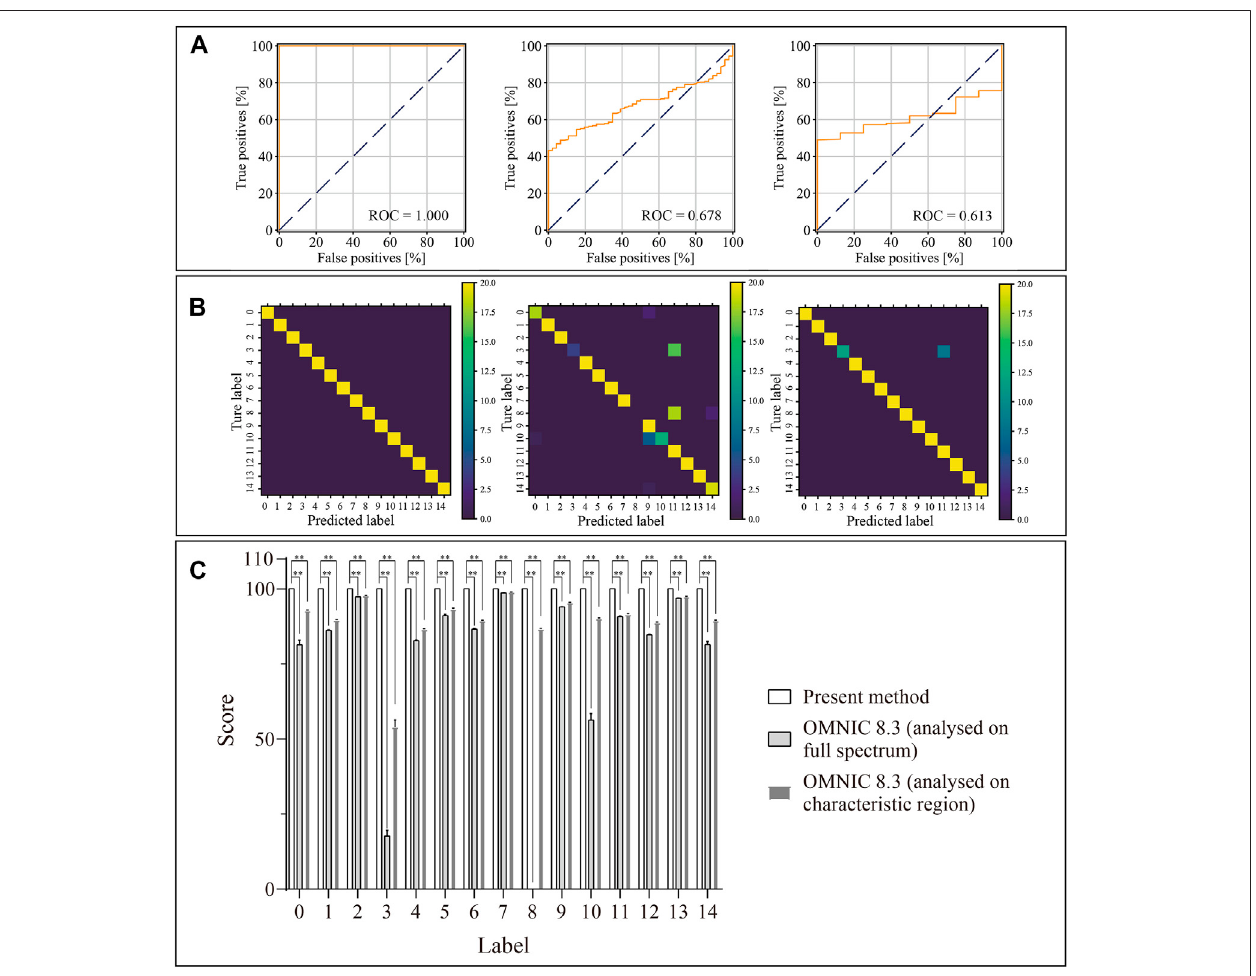
FIGURE 6 | Predicted results of the 15 therapeutic mAbs using the presented method, OMNIC 8.3 software (analysed on the full spectrum) and OMNIC 8.3 software (analysed on the characteristic region). (A) Receiver operating characteristic curves of the present algorithm, OMNIC 8.3 software build-in algorithm (analysed on full spectrum) and OMNIC 8.3 software build-in algorithm (analysed on characteristic region); (B) Confusion matrixes of the presented method, OMNIC 8.3 software build-in algorithm (analysed on full spectrum) and OMNIC 8.3 software build-in algorithm (analysed on characteristic region) are plotted based on the matching extent between the predicted labels and true labels; (C) The matching scores are calculated by model prediction using test samples ( n = 20). ** p < 0.01.